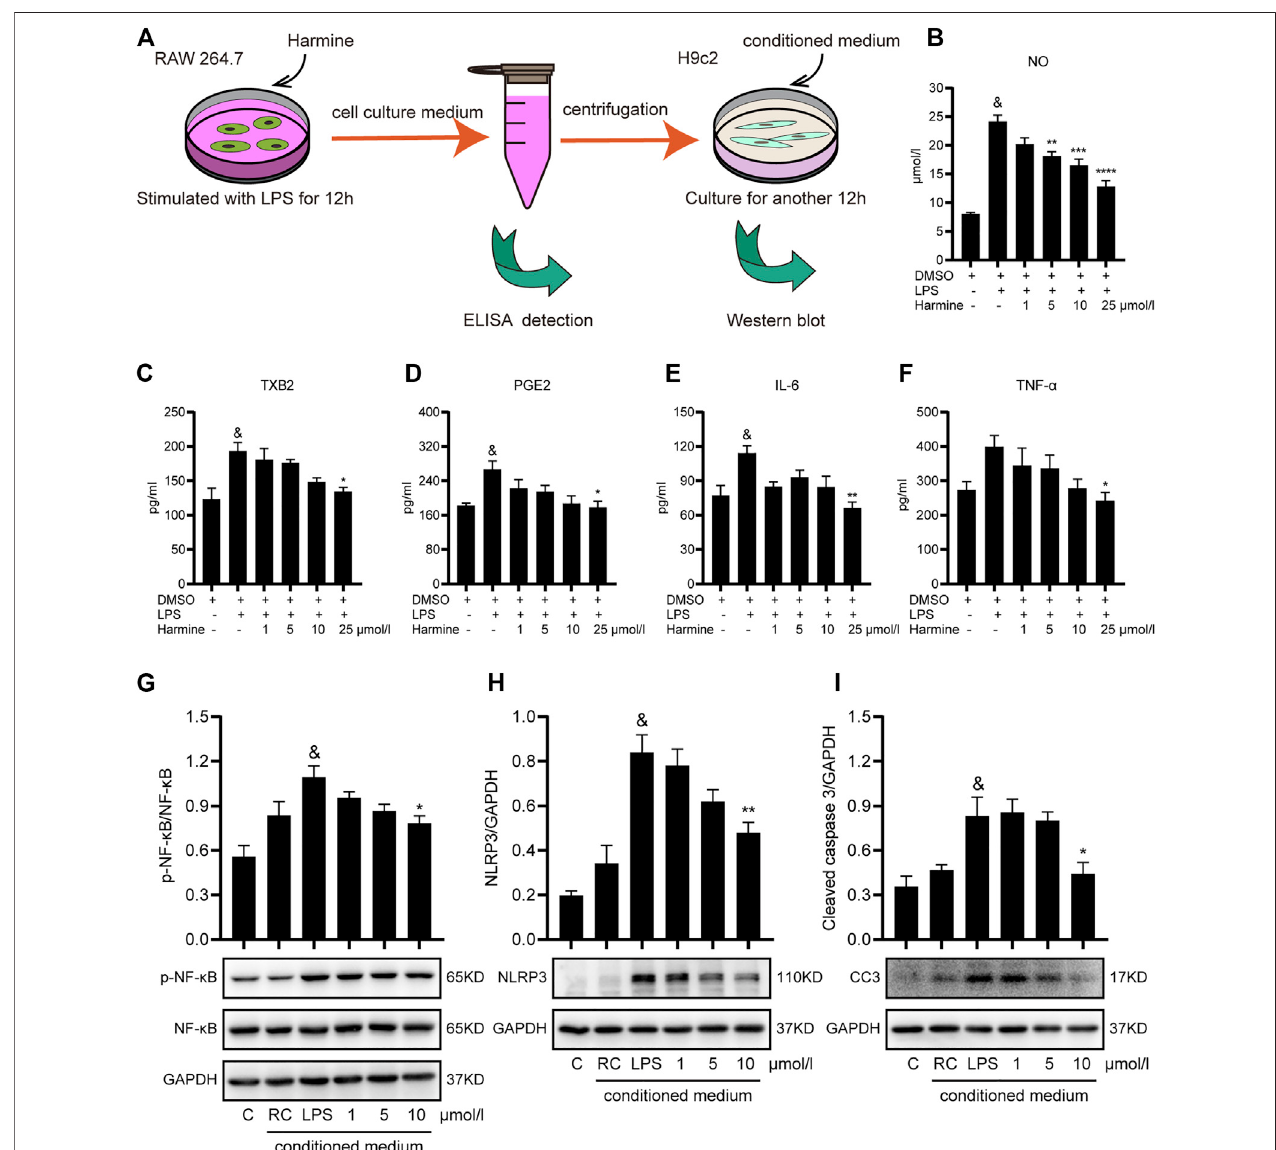
FIGURE2| Harmineattenuatedin fl ammationinRAW264.7cellsandconditionedmedium-treatedH9c2cells. (A) DiagramofconditionedmediumtreatmentofH9c2cells.RAW 264.7cellswerepretreatedwithharmine(5and25 μ mol/L)for1 handthenstimulatedwithLPS(1 μ g/ml)for12 h.ThemediumwascollectedinEPtubesandthencentrifuged.The supernatants were subjected toELISAs,andharmine-conditioned medium(1, 5, or 10 μ mol/L) wassubsequently incubatedwith H9c2 cellsforanother 12 h. H9c2celllysates were collectedforwesternblottingafterculture. (B – F) Thelevelsofthefollowingin fl ammatorymediatorsinthesupernatantscollectedfromRAW264.7cellsweredetectedusingGriess reactionorELISAs:NO,TXB2,PGE2,IL6,andTNF- α ( n (cid:1) 4). (G – I) Levelsofthep-NF- κ B( n (cid:1) 5),NF- κ B( n (cid:1) 5),NLRP3( n (cid:1) 4),andcleavedcaspase3( n (cid:1) 4)proteinsinconditioned medium-treatedH9c2cells.ConditionedmediumfromRAW264.7cells:RAWcontrolgroup(RC),1,5,and10 μ mol/L.GAPDHwasusedastheinternalcontrolforwesternblotting. Data are presented as the means ± SEM, & p < 0.05 compared with the control group; * p < 0.05, ** p < 0.01, *** p < 0.001, and **** p < 0.0001 compared with the LPS group.